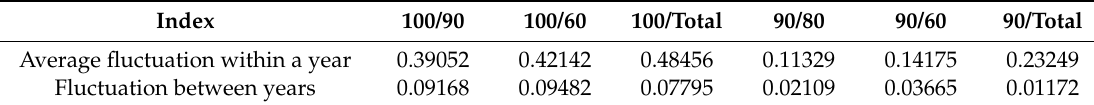
Table 4. Fluctuation of each blue zone evaluation index.